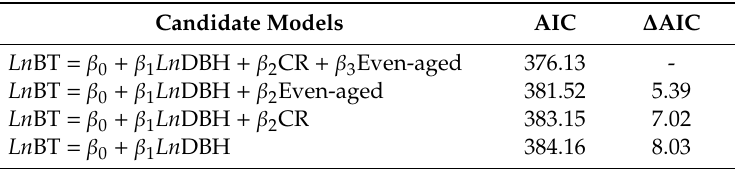
Table 9. Comparing candidate redwood bark thickness (BT) models. Generalized linear models for natural log ( Ln )-transformed BT (mm) as a function of the candidate predictor variables: DBH, crown ratio (CR), and a dummy variable for redwood trees in even-aged stands versus understory trees in multiaged stands in Jackson Demonstration State